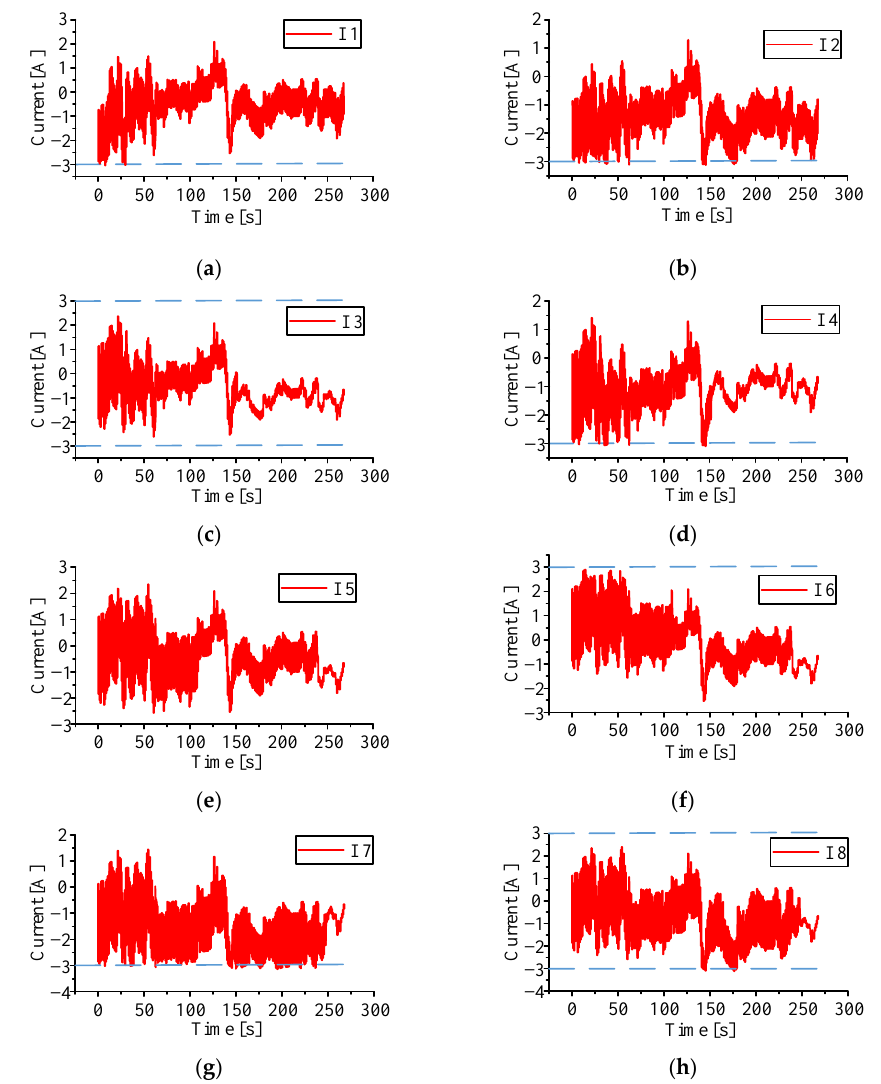
Figure 8. Lithium battery SOC change chart. (Multi-layer equalisation circuits and equalisation strategies in this paper)